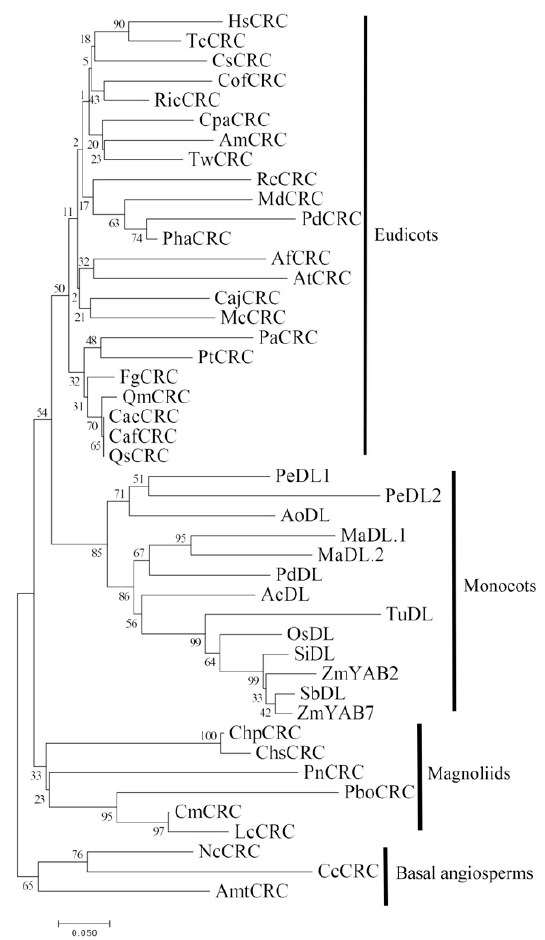
Figure 4. Phylogenetic tree of CRC/DL proteins from magnoliids and various angiosperms. The phylogenetic tree was constructed with the NJ method using MEGA 7.0 software. Bootstrap analysis was conducted with 1000 replications. The same acronym represents the same species: Cm: C.